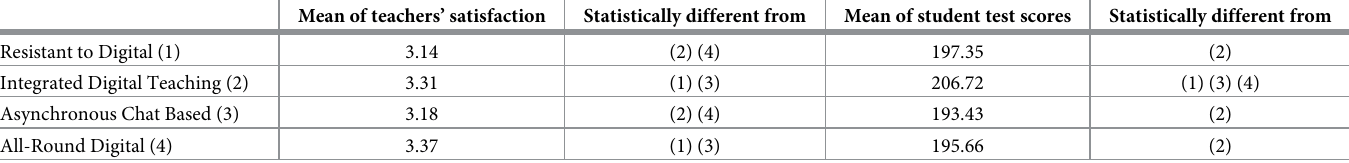
Table 4. Step 3—Chi-Square test to investigate whether subgroups differ in their perceived satisfaction and student test